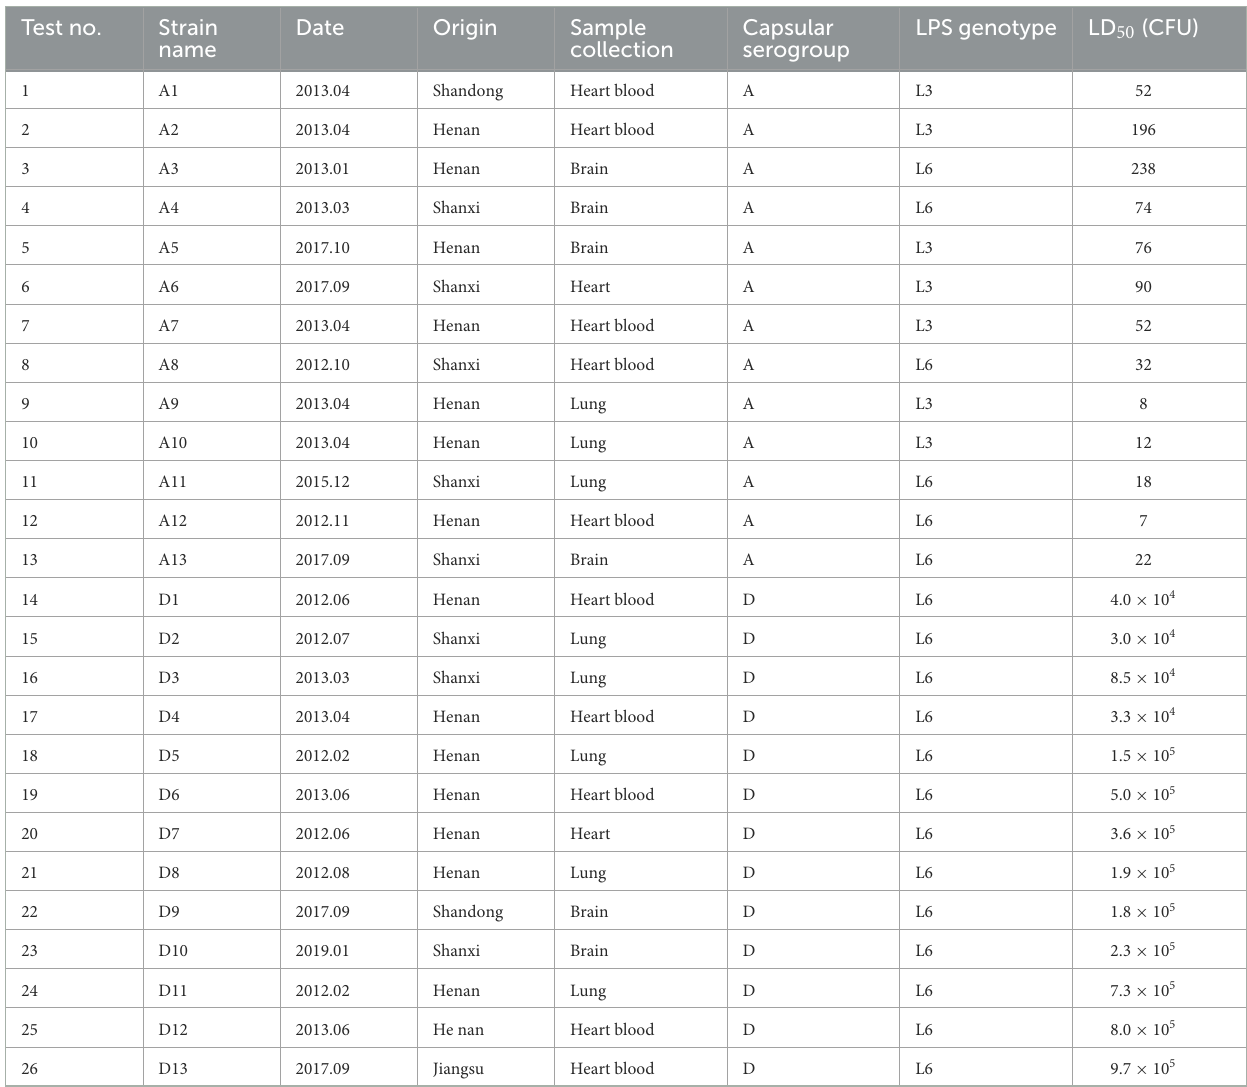
TABLE 1 Virulence results of P. multocida serogroup A and D strains in mice. Test